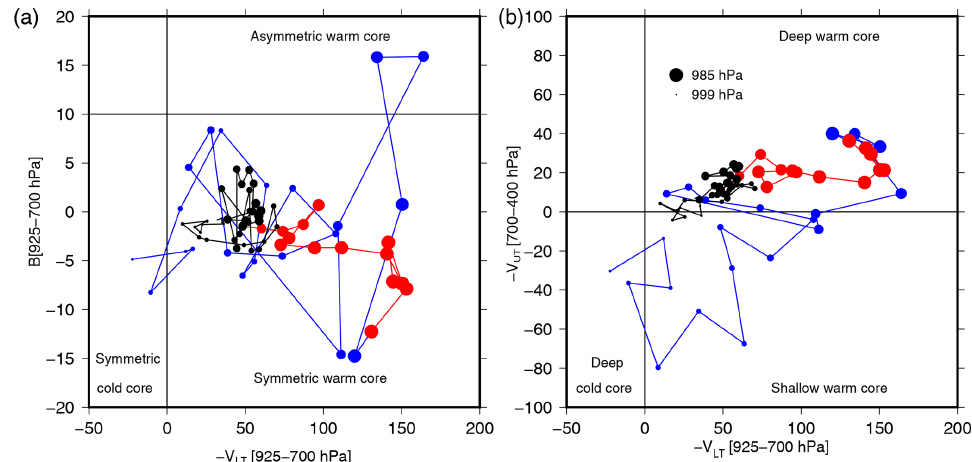
Figure 6. Phase diagram of the NOCPL-simulated cyclone from 01:00UTC on 7 November to 12:00UTC on 8 November, with low- tropospheric thickness asymmetry inside the cyclone ( B ) with respect to low-tropospheric thermal wind ( − V LT ) (a) and upper-tropospheric thermal wind ( − V UT ) with respect to low-tropospheric thermal wind (b) . The development phase is in blue, the mature phase in red and the decay phase in black.